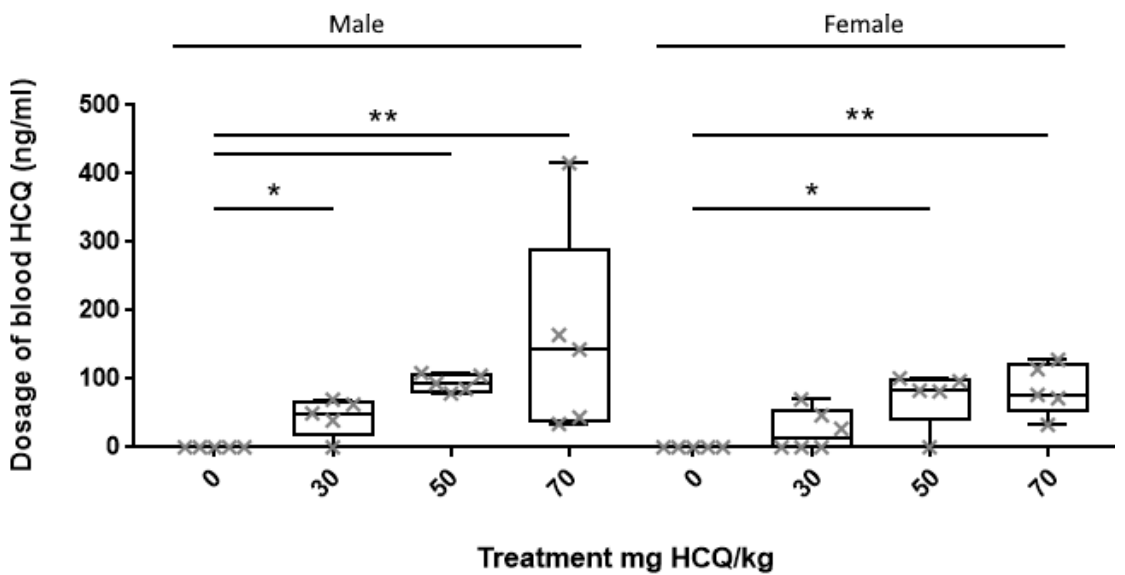
Figure 2. Dosage of blood HCQ expressed by gender at D3. Each cross represents one animal’s dosage. Boxplot expressed median and quartile. Dosages were analysed by the Kruskal–Wallis test. Mann–Whitney was used for multiple comparisons. * p < 0.05; ** p < 0.01.